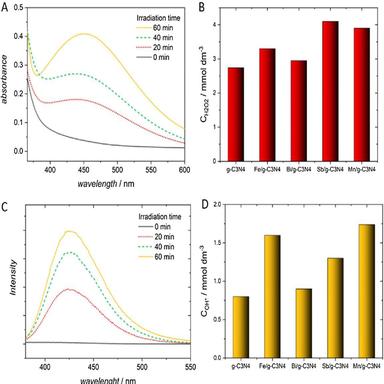
The detection of reactive oxygen species on photocatalyst under irradiation. A - spectra of peroxovanadate complex formed due to reaction of V2O5 with H2O2 in the presence of g-C3N4 in suspension saturated with oxygen. B – comparison of amount of formed H2O2 during 1-h irradiation of various photocatalysts. C – changes of fluorescence spectra indicating oxidation of terephtalic acid to 2-hydroxyterephthalic acid in the presence of g-C3N4. λexc =315 nm. D – comparison of amount of formed hydroxyl radical du